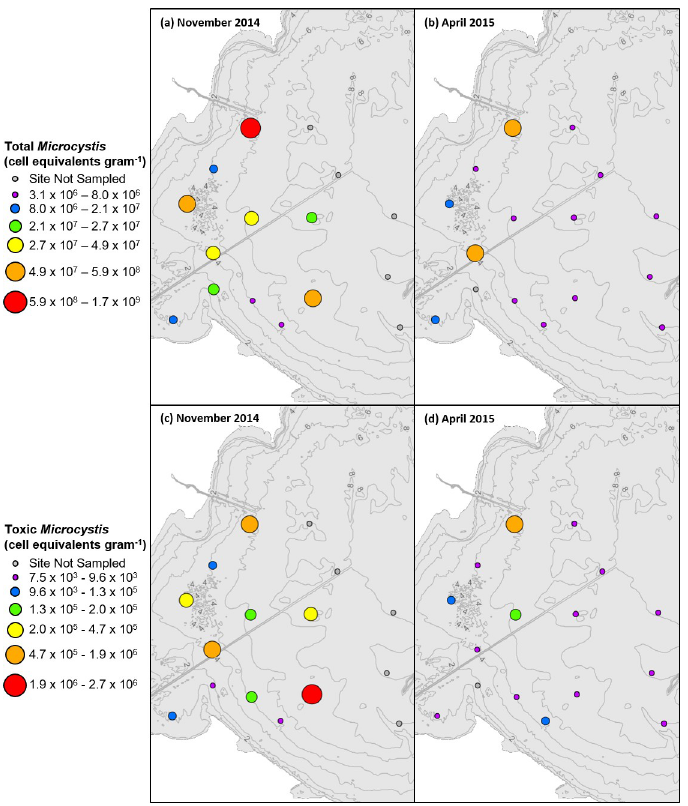
Fig 2. Total Microcystis cell equivalents in (a) November 2014 compared to (b) April 2015 per gram dry sediment and potentially-toxic Microcystis cell equivalents in (c) November 2014 and (d) April 2015 per gram dry sediment. Ranges for each category selected based on ArcGIS quantile classification of November 2014 data.